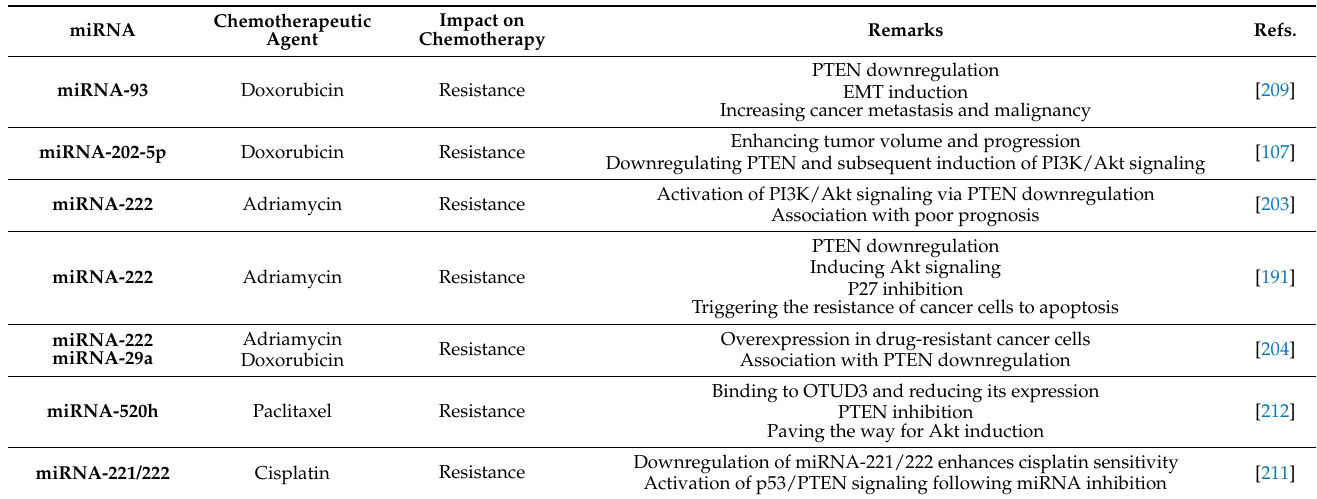
Table 3. miRNAs regulating PTEN signaling in breast cancer